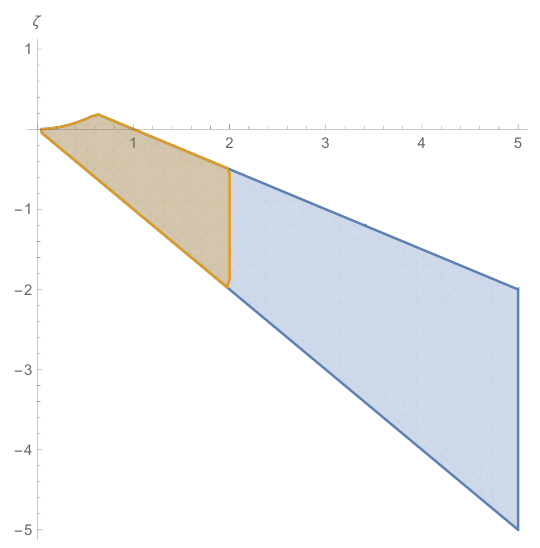
Figure 1 . Parameter space ( (cid:17); (cid:16) ) where the low energy transverse spectral weight diverges for k (cid:20) k ? (brown region). The union of the two colored regions shows the full parameter